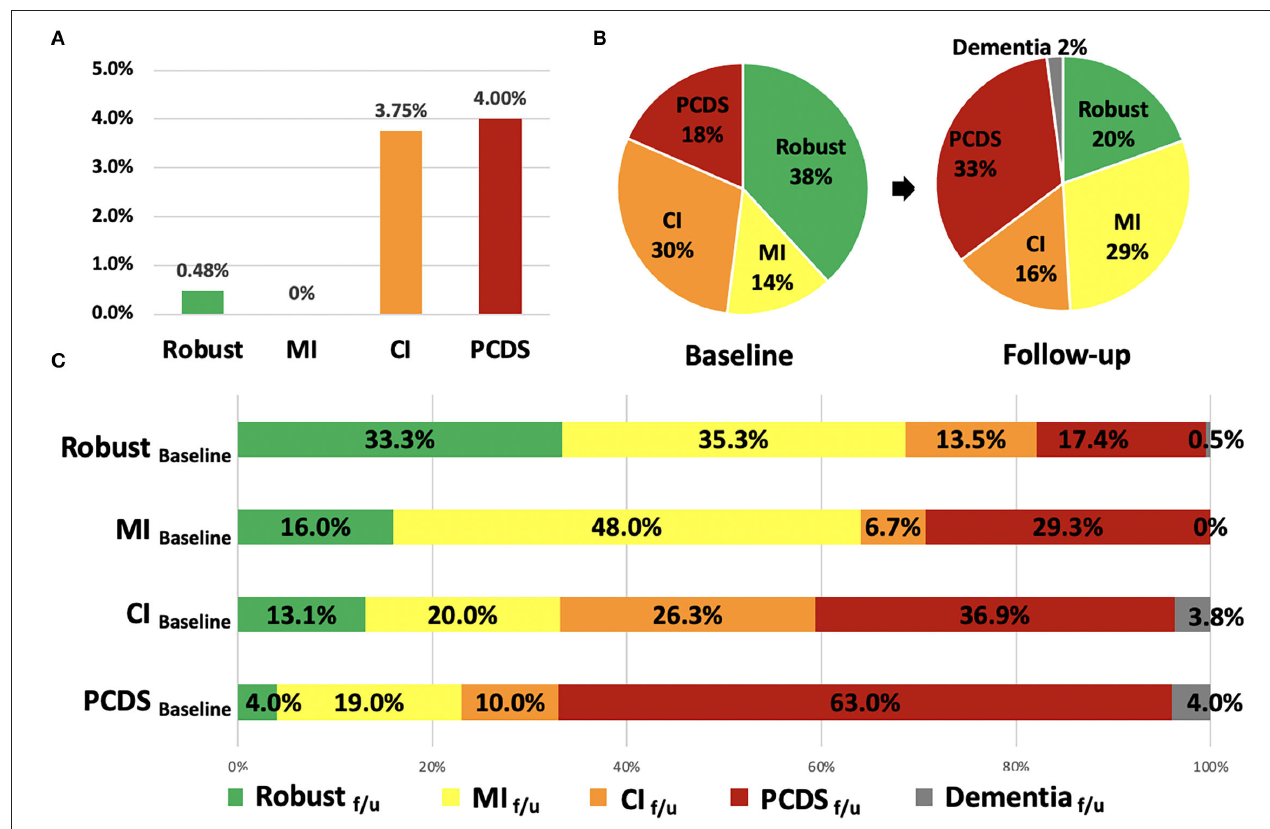
FIGURE 1 | The incidence of dementia, the distribution and transitions of robust, physical frailty, CI, and PCDS groups at the first and follow-up visit. (A) The incidence of dementia in the four groups after 2.5 years. (B) The distribution of robust, physical frailty, CI, and PCDS groups at the first and follow-up visits. (C) The categorical transitions at the follow-up visit in four categories. CI, cognitive impairment; MI, mobility impairment; PCDS, physio-cognitive decline syndrome.